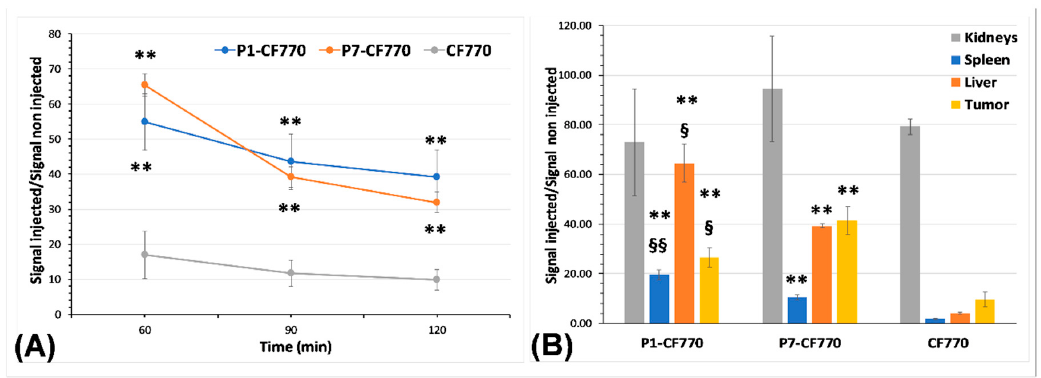
Figure 9. Measurement of the signal intensity using the M3Vision software on in vivo ( A ) and ex vivo ( B ) FLI images. The results are normalized to the signal measured on non-injected mice and organs and are expressed as means ± SD. One-way ANOVA was used to evaluate the statistical difference between the experimental groups: ** = p < 0.01 vs. CF770; § = p < 0.05, §§ = p < 0.01 for P1-CF770 vs. P7-CF770. Table 2. Estimation of true positive (TP), false positive (FP), true negative (TN), and false negative (FN) cases within the experimental groups of mice injected with P1-CF770, P7-CF770 or CF770 alone. The results obtained at 2 h after the injection of imaging probes were normalized to the signal measured on non-injected mice and exploited to finally estimate the sensitivity and specificity of the three near-infrared (NIR) imaging probes.